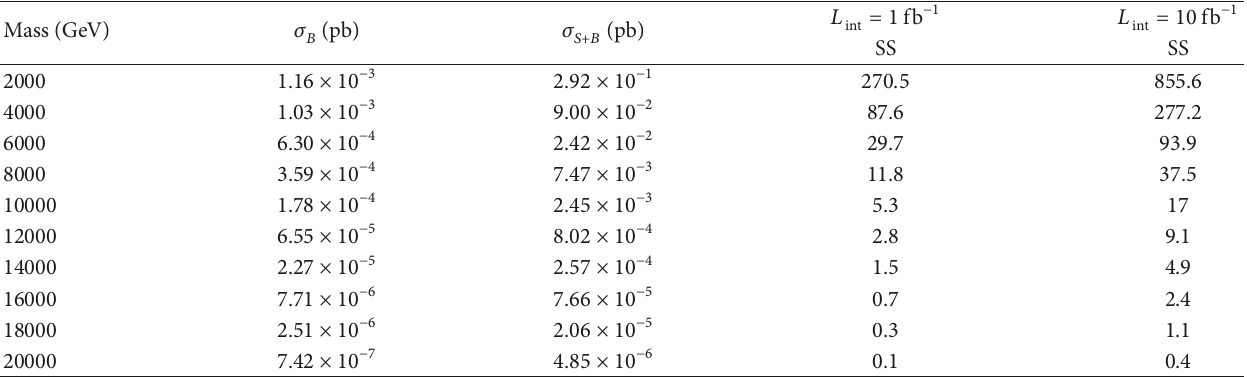
Table4:Thestatisticalsignificance(SS)valuesandthecrosssectionsoftheexcitedneutrinosignalandrelevantbackgroundatthePWFA-LC